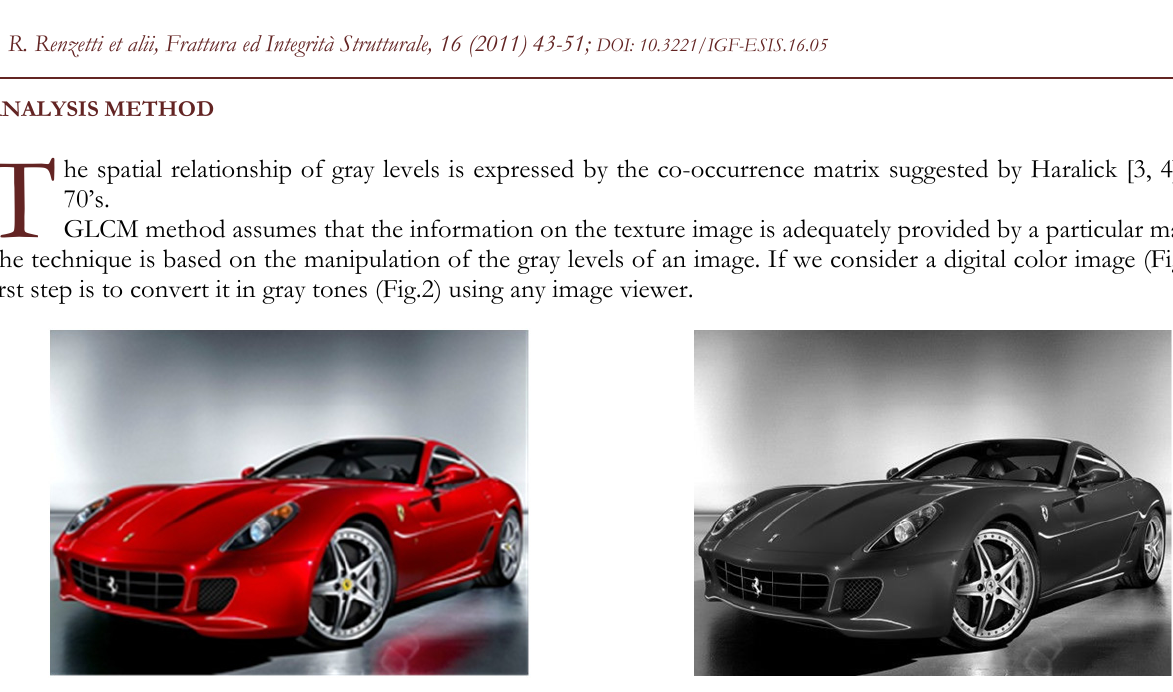
Figure 1: Digital color image. Figure 2: Gray tones image (256 levels).